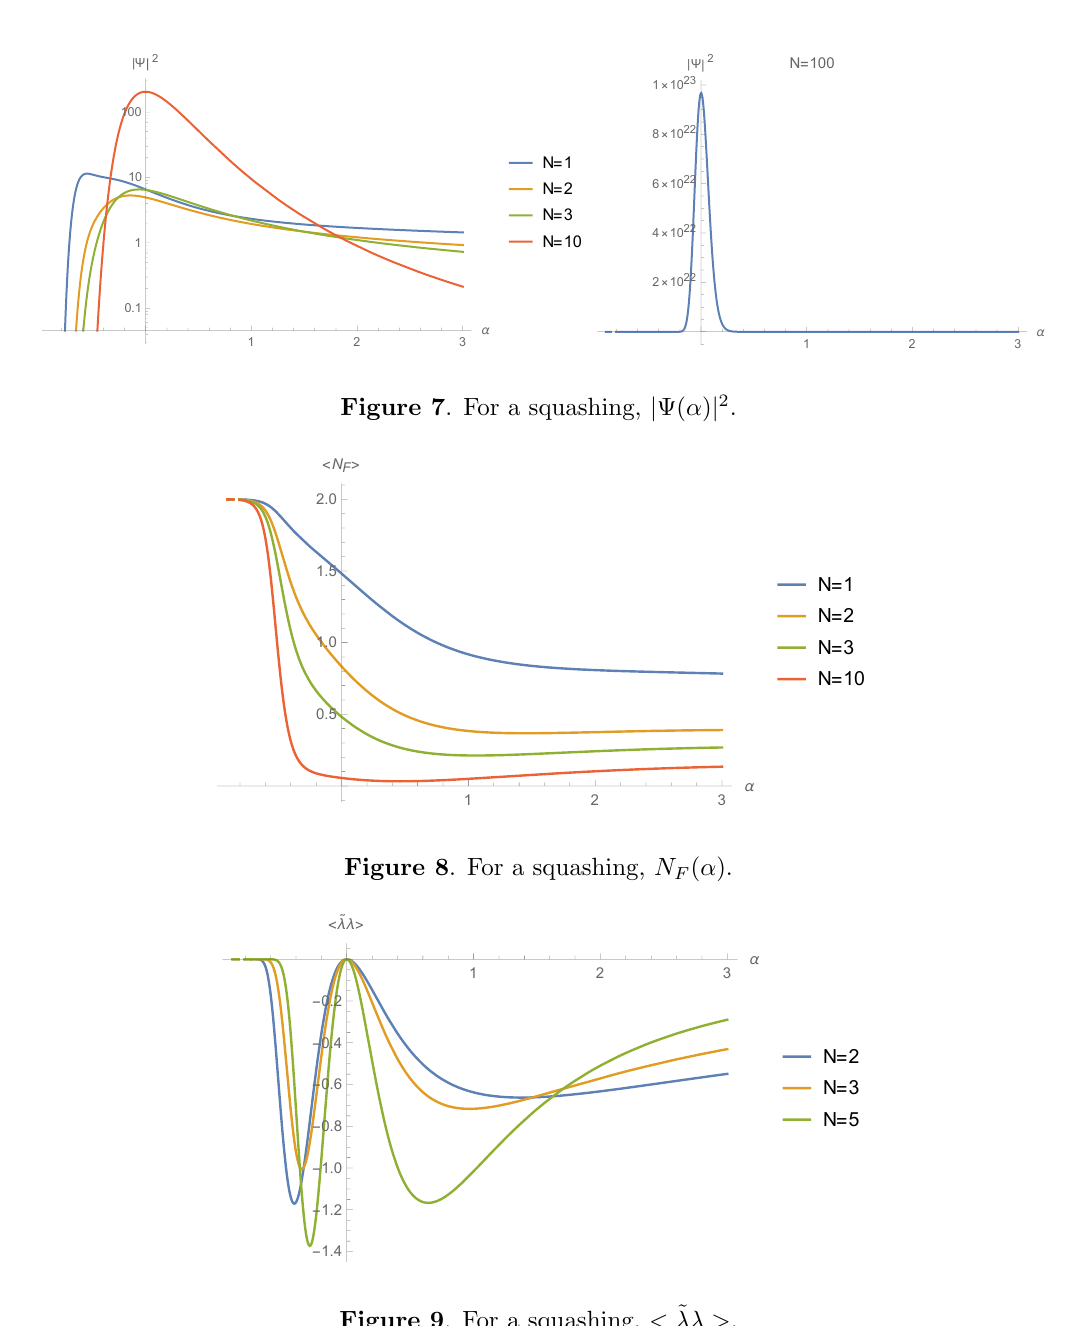
Figure 9 . For a squashing, < ~ (cid:21)(cid:21) >